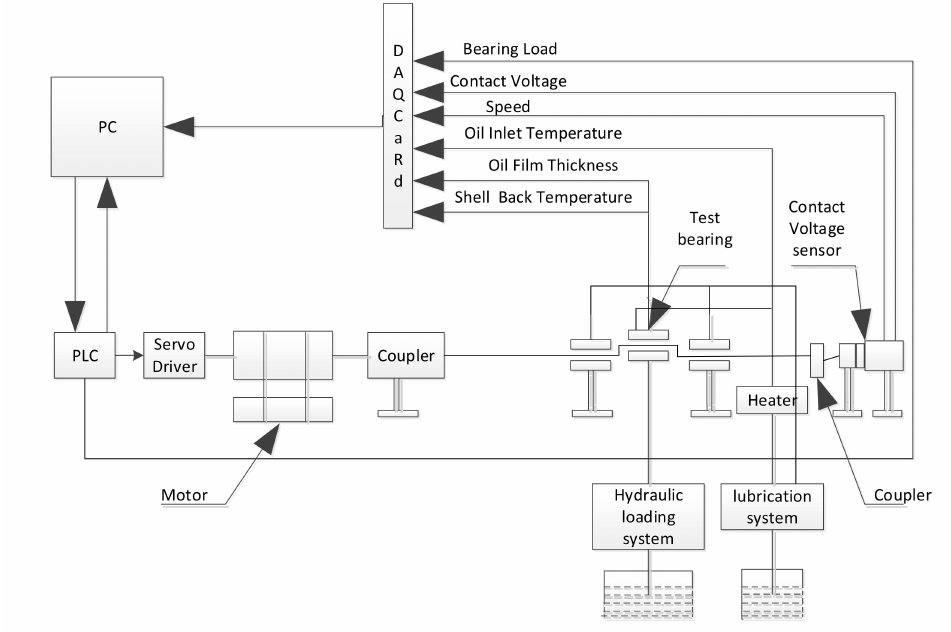
Figure 2. Schematic diagram of the “Sapphire” test